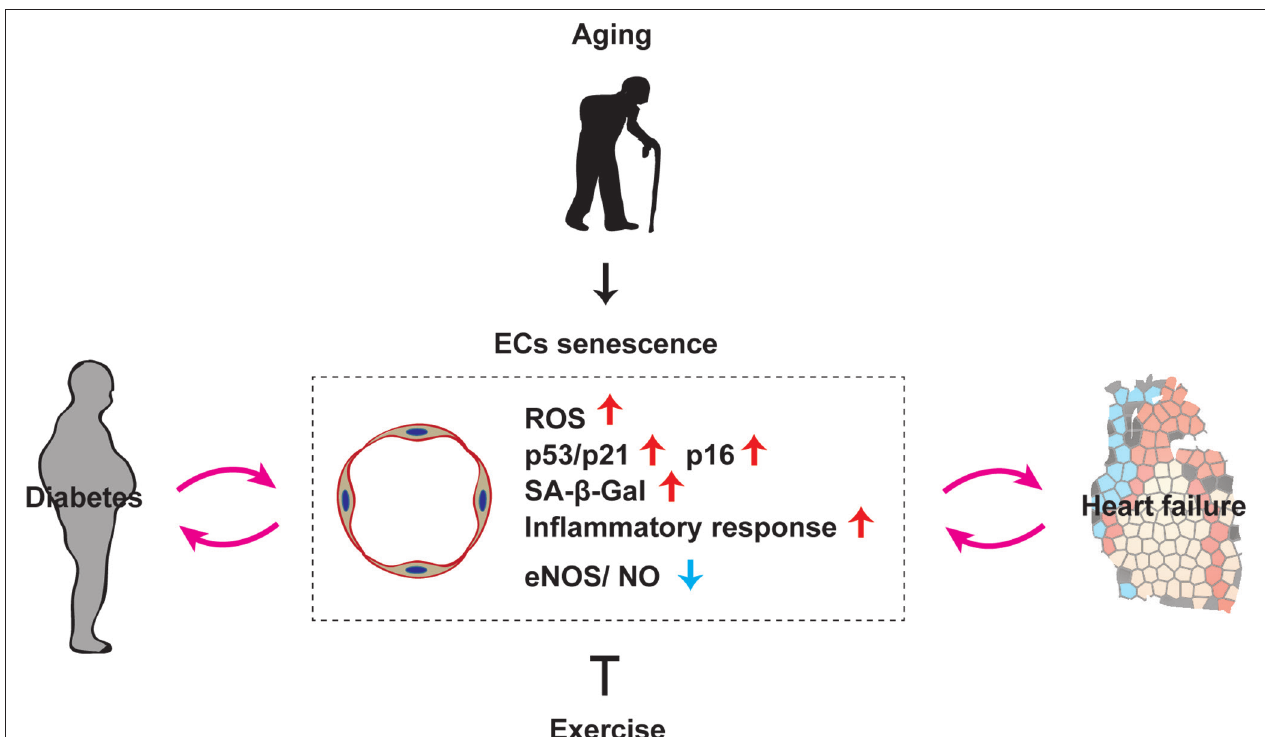
FiguRe 2 | Role of endothelial senescence in cardio-metabolic disease. Chronological aging induces vascular endothelial cell senescence (EC senescence as characterized with an increase of ROS, p53/p21, p16, SA- β -Gal, inflammatory response, and reduced eNOS/NO level). EC senescence has a pivotal role in the progression of diabetes and heart failure. Exercise has a potential to suppress ECs